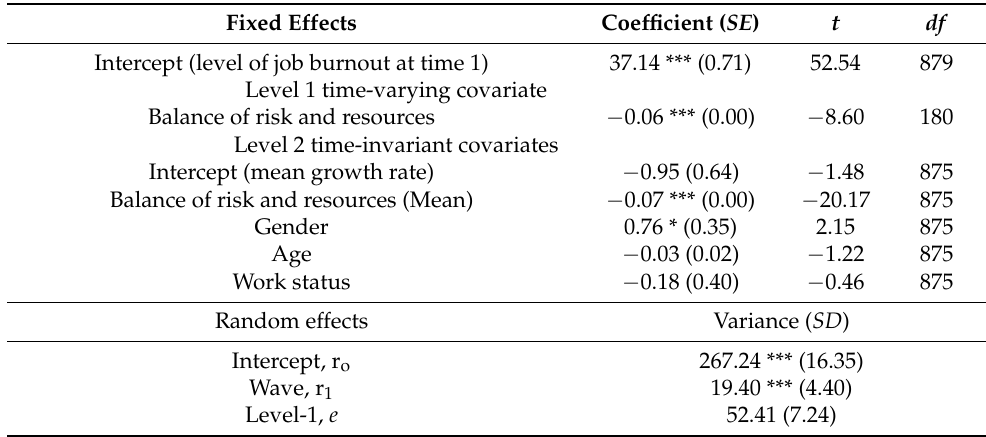
Table 4. Results of the HLM conditional models of the balance of risk and resources, gender, age and work status predicting change in job